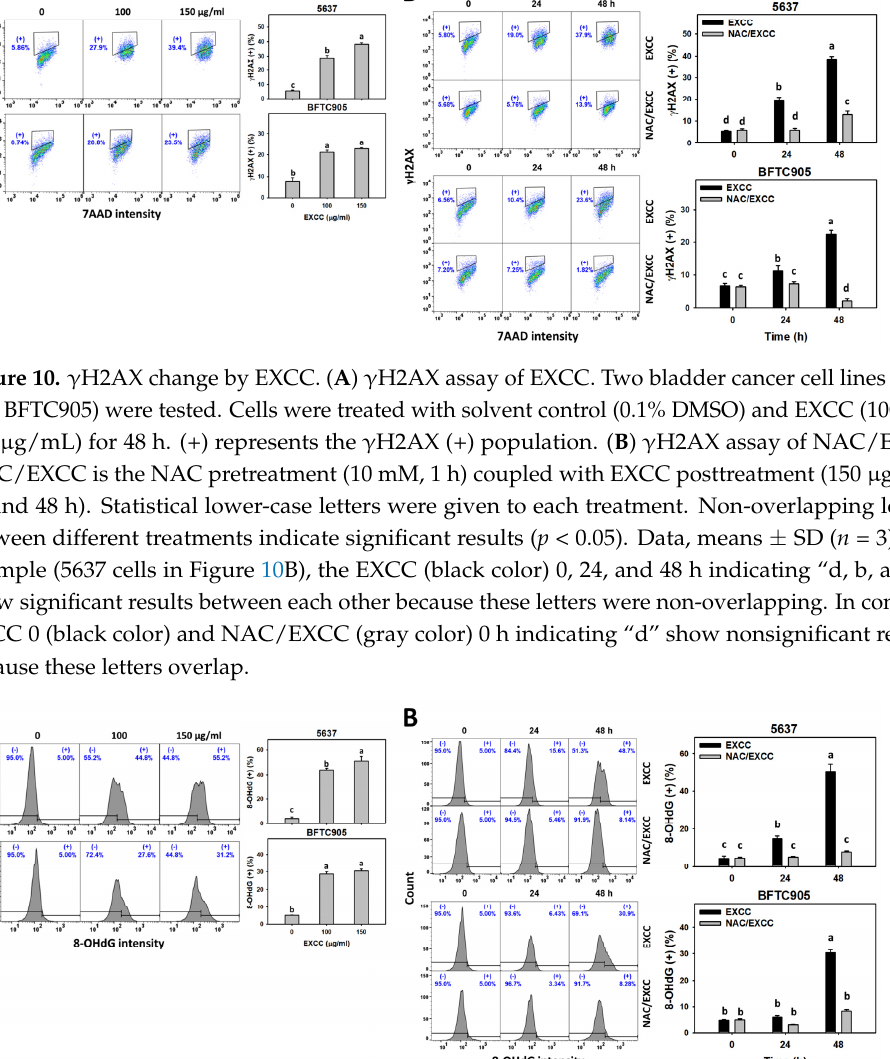
Figure 11. 8-OHdG change by EXCC. ( A ) 8-OHdG assay of EXCC. Two bladder cancer cell lines (5637 and BFTC905) were tested. Cells were treated with control (0.1% DMSO) and EXCC (100 and 150 μ g/mL) for 48 h. (+) represents the 8-OHdG (+) population. ( B ) 8-OHdG assay of NAC/EXCC. NAC/EXCC is the NAC pretreatment (10 mM, 1 h) coupled with EXCC posttreatment (150 μ g/mL, 24 and 48 h). Statistical lower-case letters were given to each treatment. Non-overlapping letters between different treatments indicate significant results ( p < 0.05). Data, means ± SD ( n = 3). For example (5637 cells in Figure 11B), the EXCC (black color) 0, 24, and 48 h indicating “c, b, and a” show significant results between each other because these letters were non-overlapping. In contrast, EXCC 0 (black color) and NAC/EXCC (gray color) 0 h indicating “c” show nonsignificant results because these letters overlap.